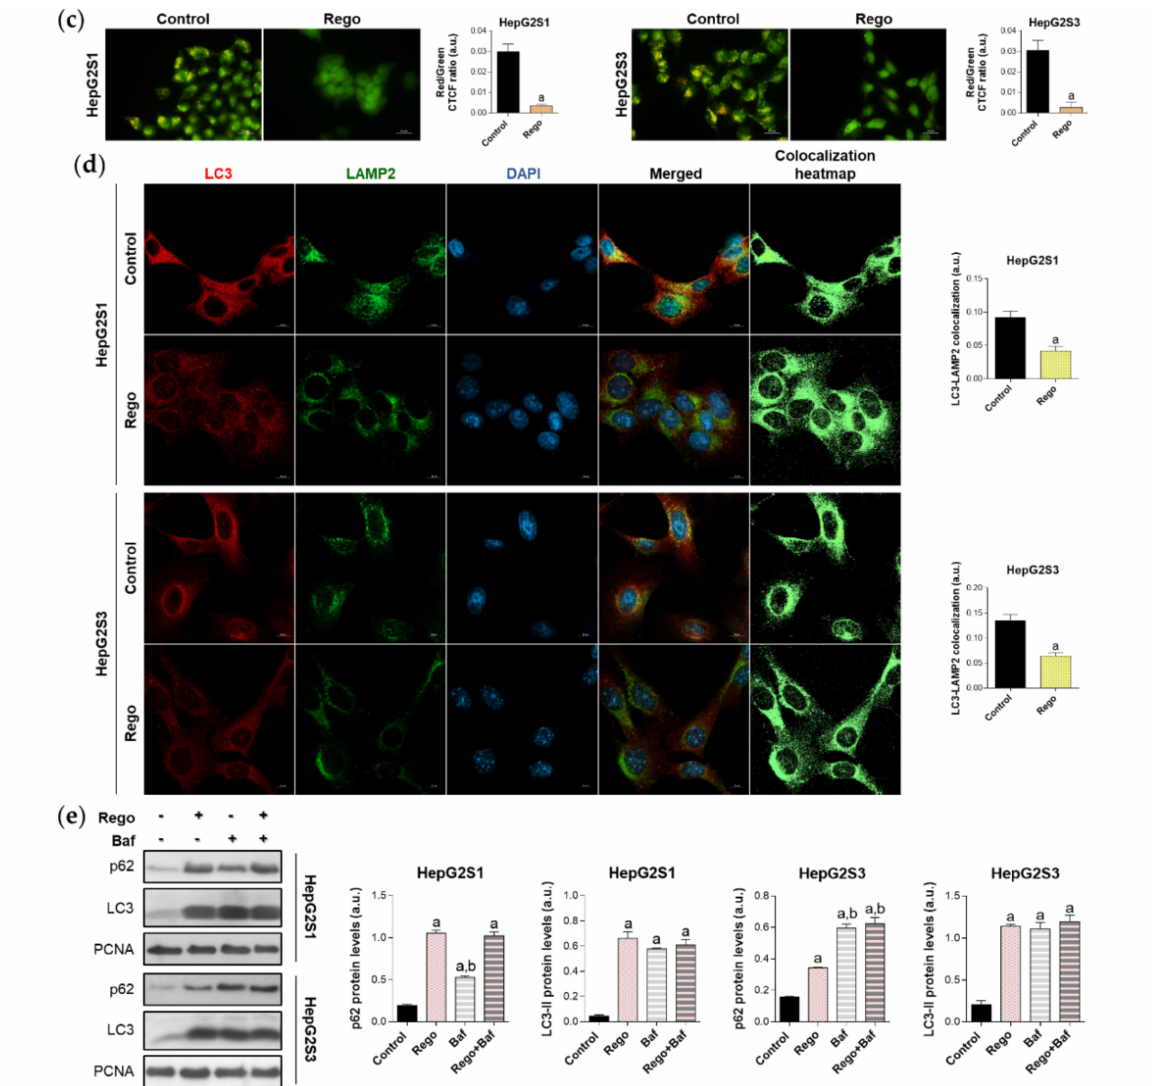
Figure 7. Impact of regorafenib treatment on the induced autophagy of HepG2S1 and HepG2S3 sorafenib-resistant cell lines. HCC cells were treated with 20 µ M regorafenib (Rego) for 48 h. ( a ) Immunoblots of FOXO3 and autophagy-related markers. Densitometry reading of each band is shown; ( b ) Assessment of FOXO3 nuclear translocation by confocal microscopy and FOXO3 immunofluorescence. Green fluorescence, FOXO3. Blue, cell nucleus. Magnification 63 × , scale bar 10 µ m. Quantification of nuclear green fluorescence (FOXO3) is also shown; ( c ) Fluorescence microscopy images from acridine orange staining. Magnification 40 × , scale bar 25 µ m. Bar graphs representing the quantification of red/green CTCF ratio are also shown; ( d ) Confocal microscopy images from LC3-LAMP2 immunofluorescence. Red fluorescence, LC3. Green, LAMP2. Blue, cell nucleus. Yellow fluorescence in merged channel shows LC3-LAMP2 colocalization. Magnification 63 × , scale bar 10 µ m. Corresponding LC3-LAMP2 colocalization heatmaps obtained using ImageJ and bar graphs representing the quantification of LC3-LAMP2 colocalization are also shown; ( e ) Immunoblots showing p62 and LC3 turnover after single or combined treatment with regorafenib and 100 nM bafilomycin A1 (Baf). In the case of bafilomycin A1 single administration, cells were exposed to this agent for 24 h while, for the co-treatment, cells were subjected to regorafenib for 48 h in presence of bafilomycin A1 during the last 24 h. Densitometry reading of each band is shown. Data from ( a – e ) are expressed as mean values of arbitrary units (a.u.) ± SD of three independent experiments. a p < 0.05 vs. control (non-treated) cells, b p < 0.05 vs. regorafenib-treated